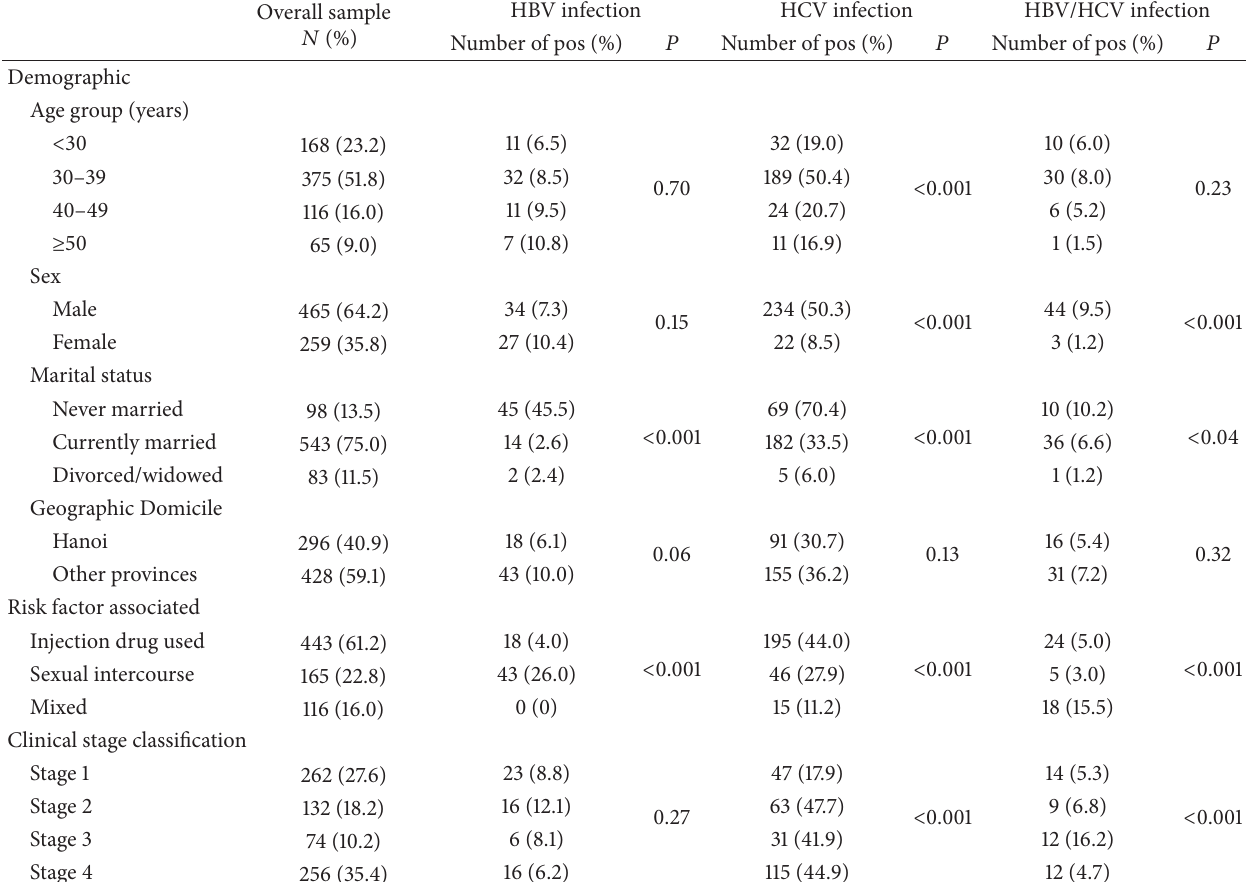
Table 1: Demographic, risk behaviors, and clinical stage at baseline of the studied population ( 𝑛 = 724